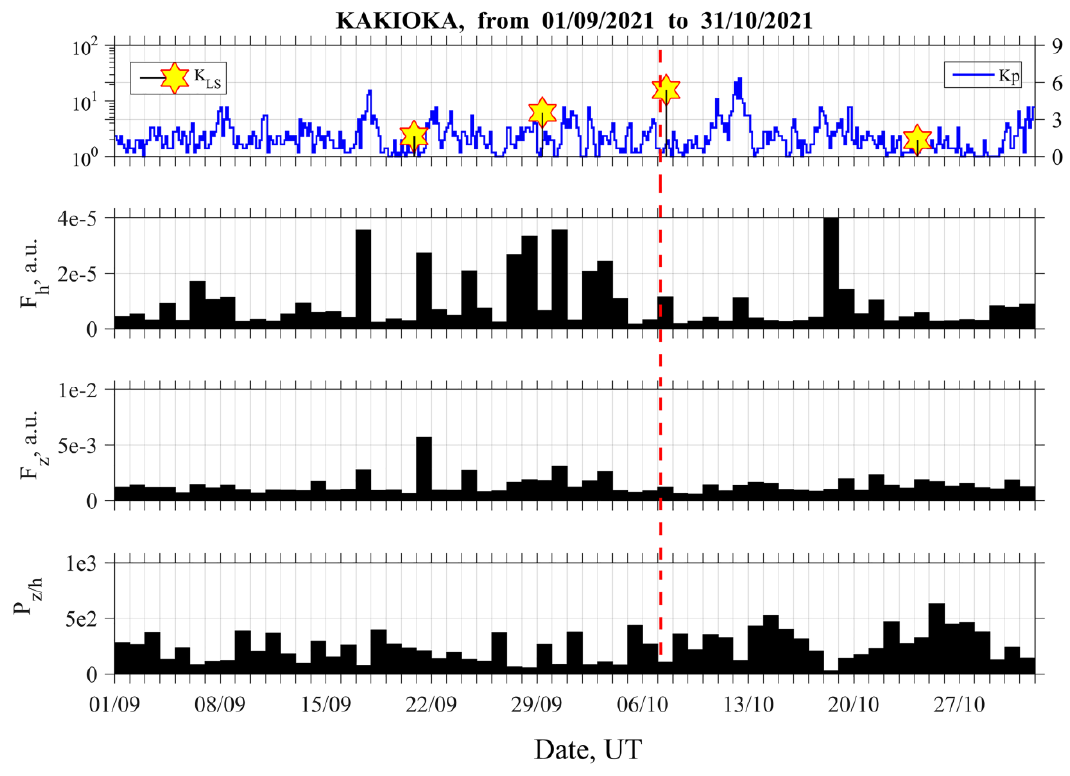
Figure 2. Different characteristics of ULF magnetic field recorded in Kakioka (KAK). Top panel refers to the magnetic ( K p ) and local seismic activity ( K LS ). A vertical dotted red line is the occurrence time of our EQ. The second and third panels refer to F h and F z , and the fourth panel indicates the polarization ( P z / h ), as characterized by the ratio of F z to F h .